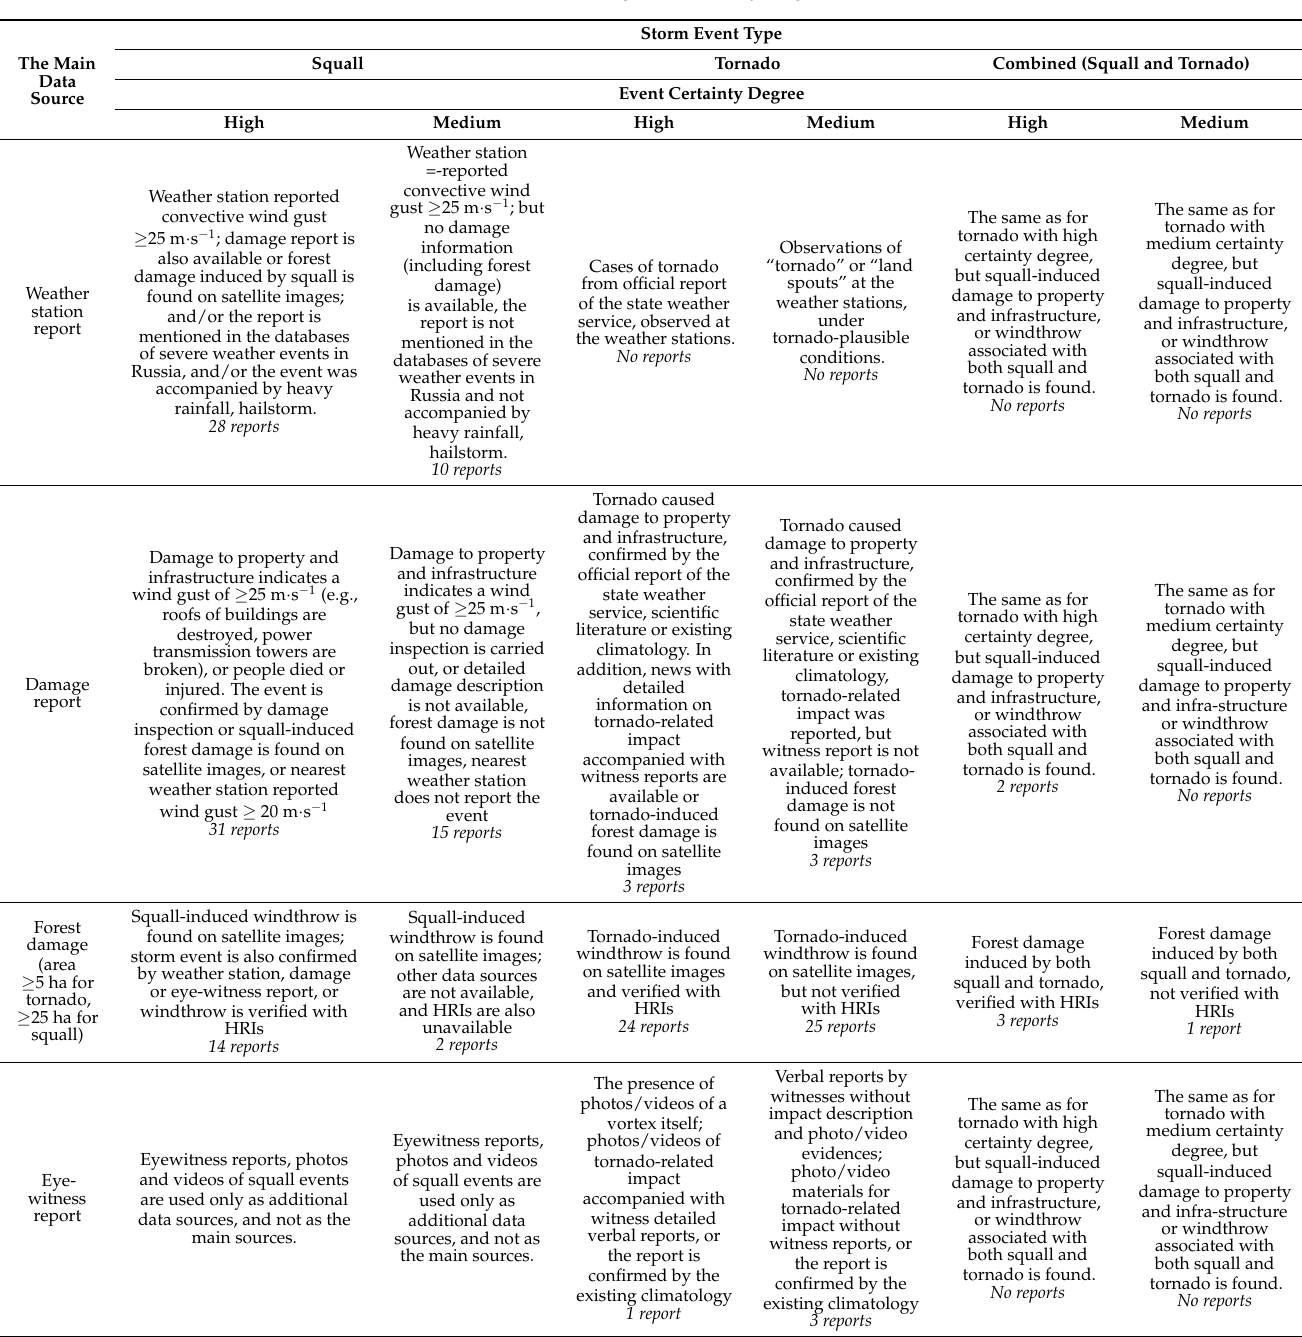
Table 1. Criteria for determining the certainty degree of storm